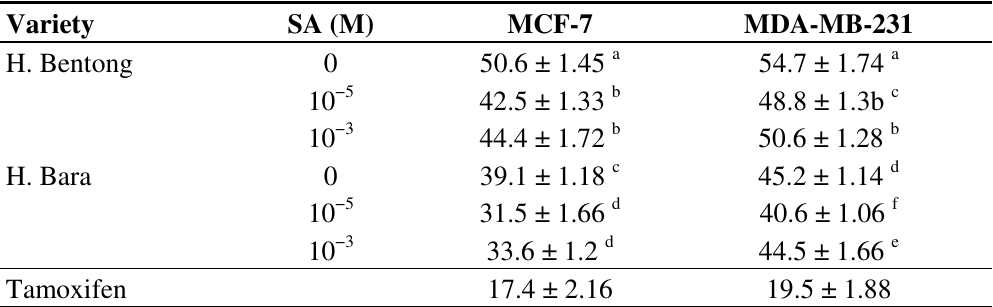
Table 4. IC values of ginger extracts towards MCF-7 and MDA-MB-231 cancer cell 50 lines as determined by the MTT